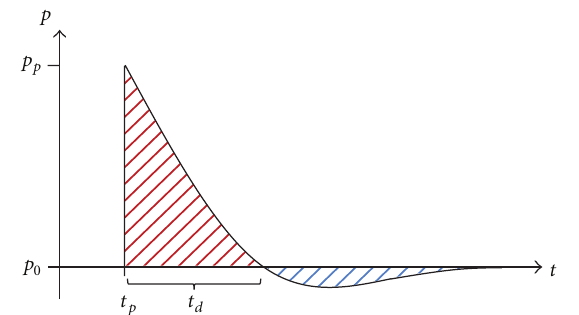
Figure 3: Typical Friedlander curve to display blast shock wave pressure versus